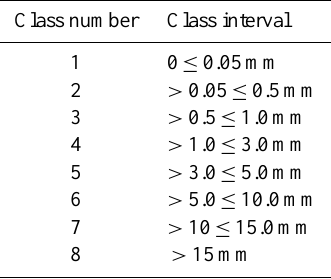
Table 1. Class numbers of CPs and their intervals of spatially aver- aged daily precipitation according to Enke et al. (2005).